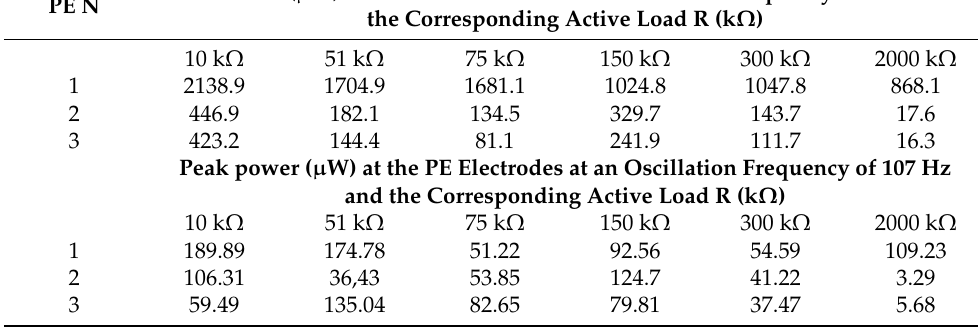
Table 8. Experimental measurements of the output power peak on the PE electrodes at the corre- sponding vibration frequencies and the corresponding active